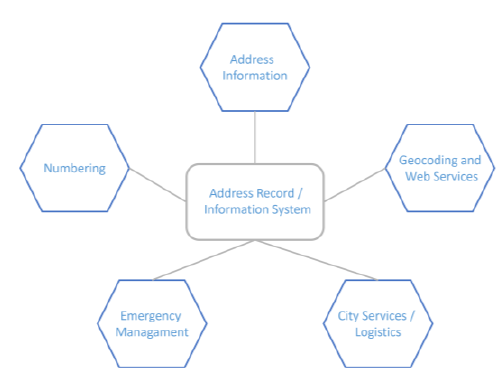
Figure 1. Address information system